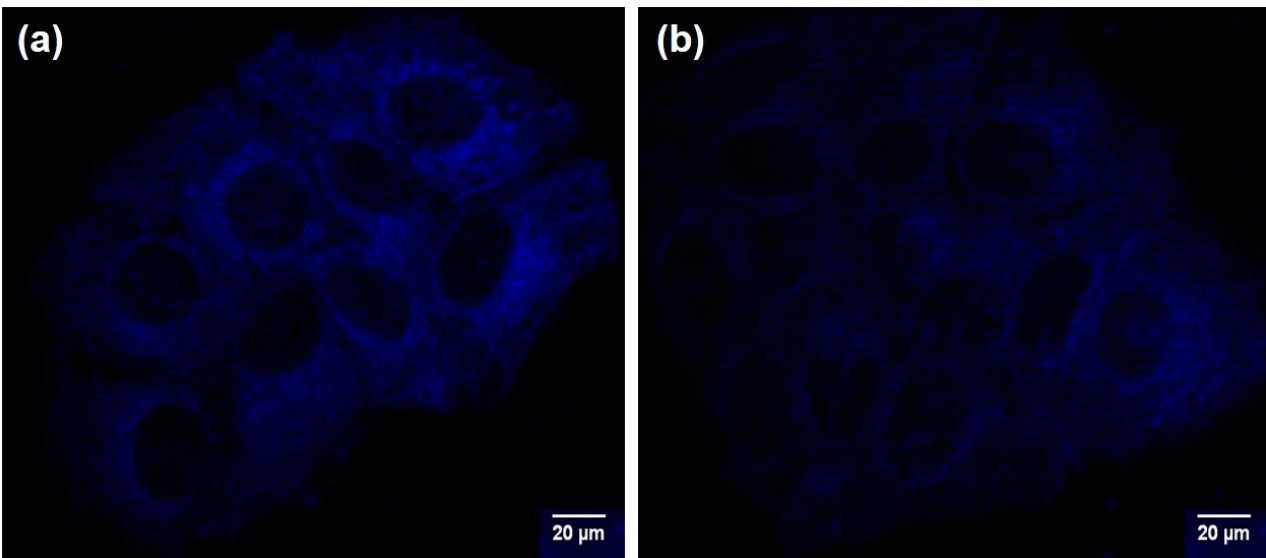
Figure 9. Consecutive (along the z axis) confocal microscopy images of MCF-7 cells after 24 h incu- bation with ( a ) Cu-1 and ( b ) L1 at a concentration of 5 µM using DAPI fi lter. The bar corresponds to 20